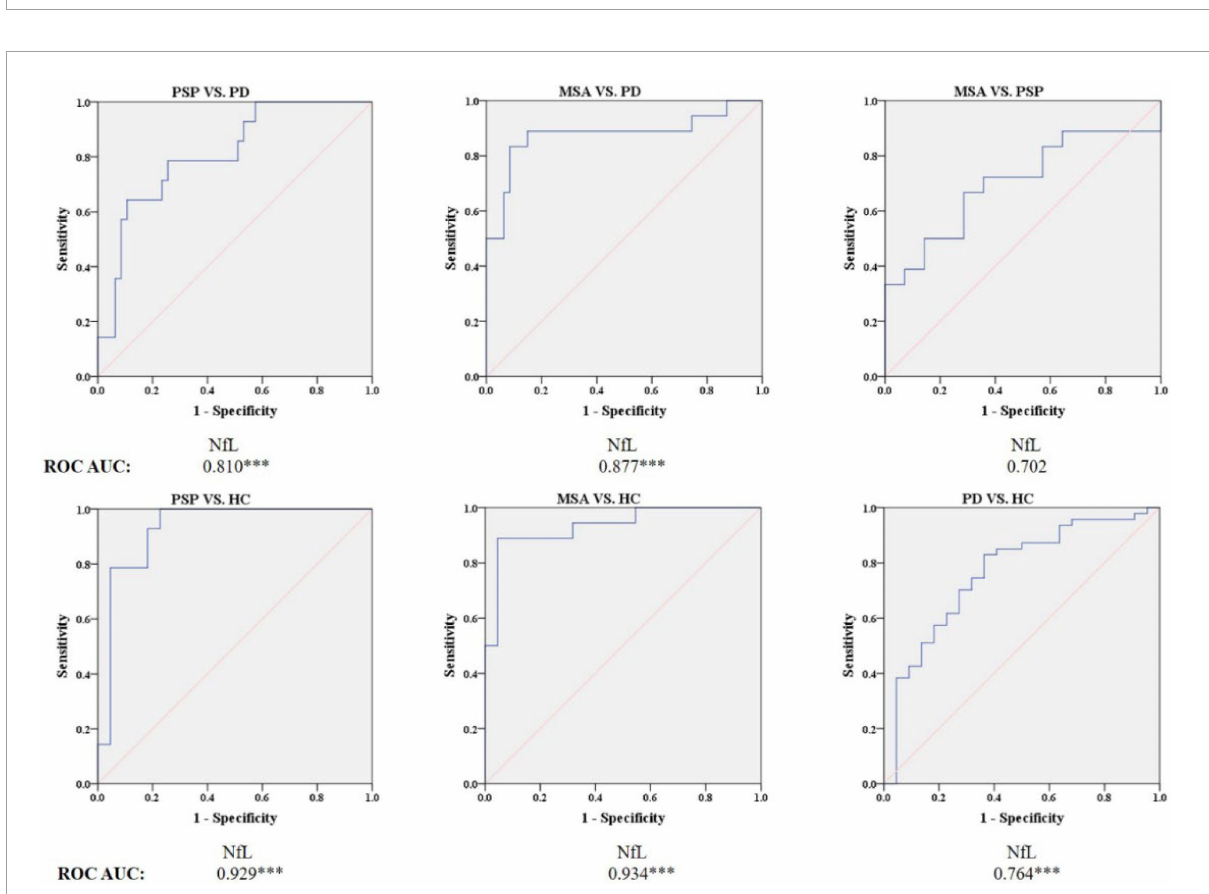
FIGURE5 Receiver operating characteristic (ROC) curves showing comparisons in plasma NfL between parkinsonian disorders and HC. ∗∗∗ P ≤ 0.001. HC, healthy control; PD, Parkinson’s disease; PSP, progressive supranuclear palsy; MSA, multiple system